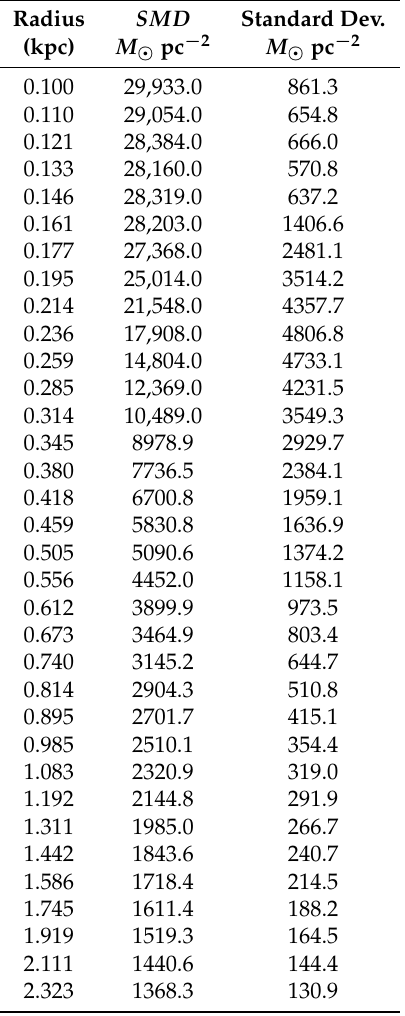
Table A3. Directly calculated SMD by spherical assumption of the mass